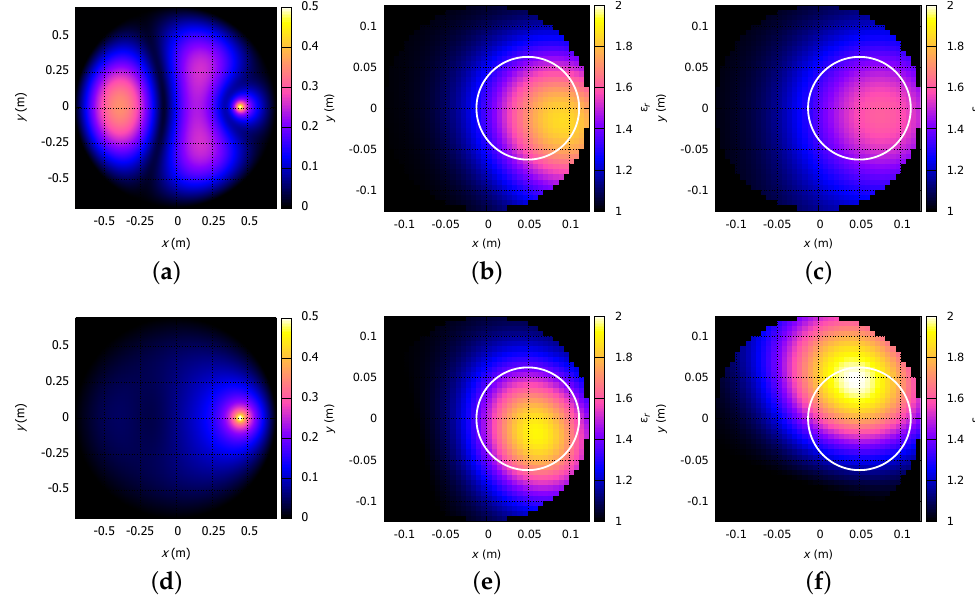
Figure 7. Examples of Green’s functions and reconstructed distributions of the relative dielectric permittivity with small conducting enclosure, a = 0.7 λ . Upper row: results with σ b = 1 mS/m: ( a ) Green’s function magnitude for a source at ( ρ s ,0 ) ; ( b ) Reconstruction with cylindrical enclosure; ( c ) Reconstruction in free space. Lower row: results with σ b = 10 mS/m: ( d ) Green’s function for point source located at ( ρ s ,0 ) ; ( e ) Reconstruction with cylindrical enclosure; ( f ) Reconstruction in free